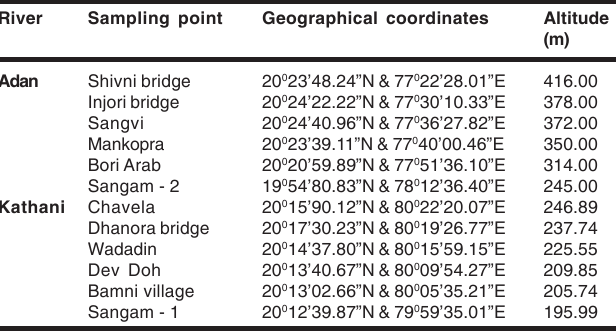
Table 1. Details of sampling